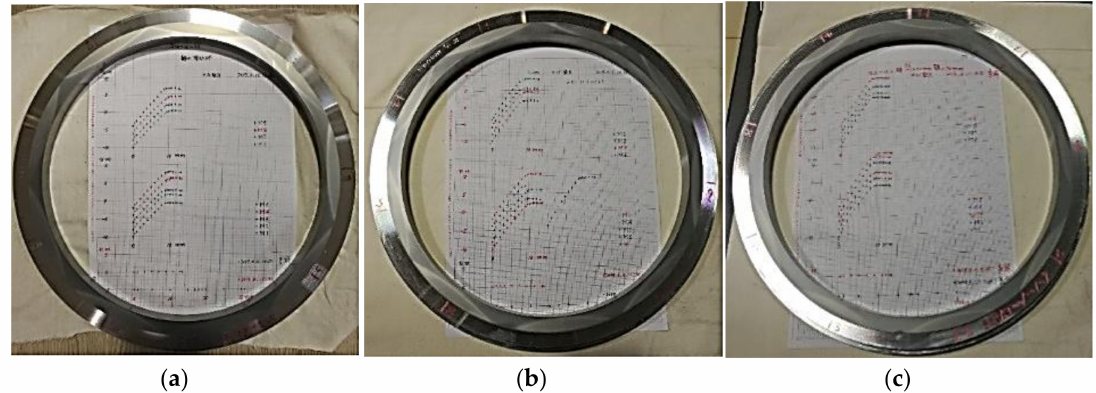
Figure 4. Manufacture status of the stationary slide rings, including ( a ) δ = 0.12 mm, ( b ) δ = 0.15 mm, ( c ) δ = 0.20